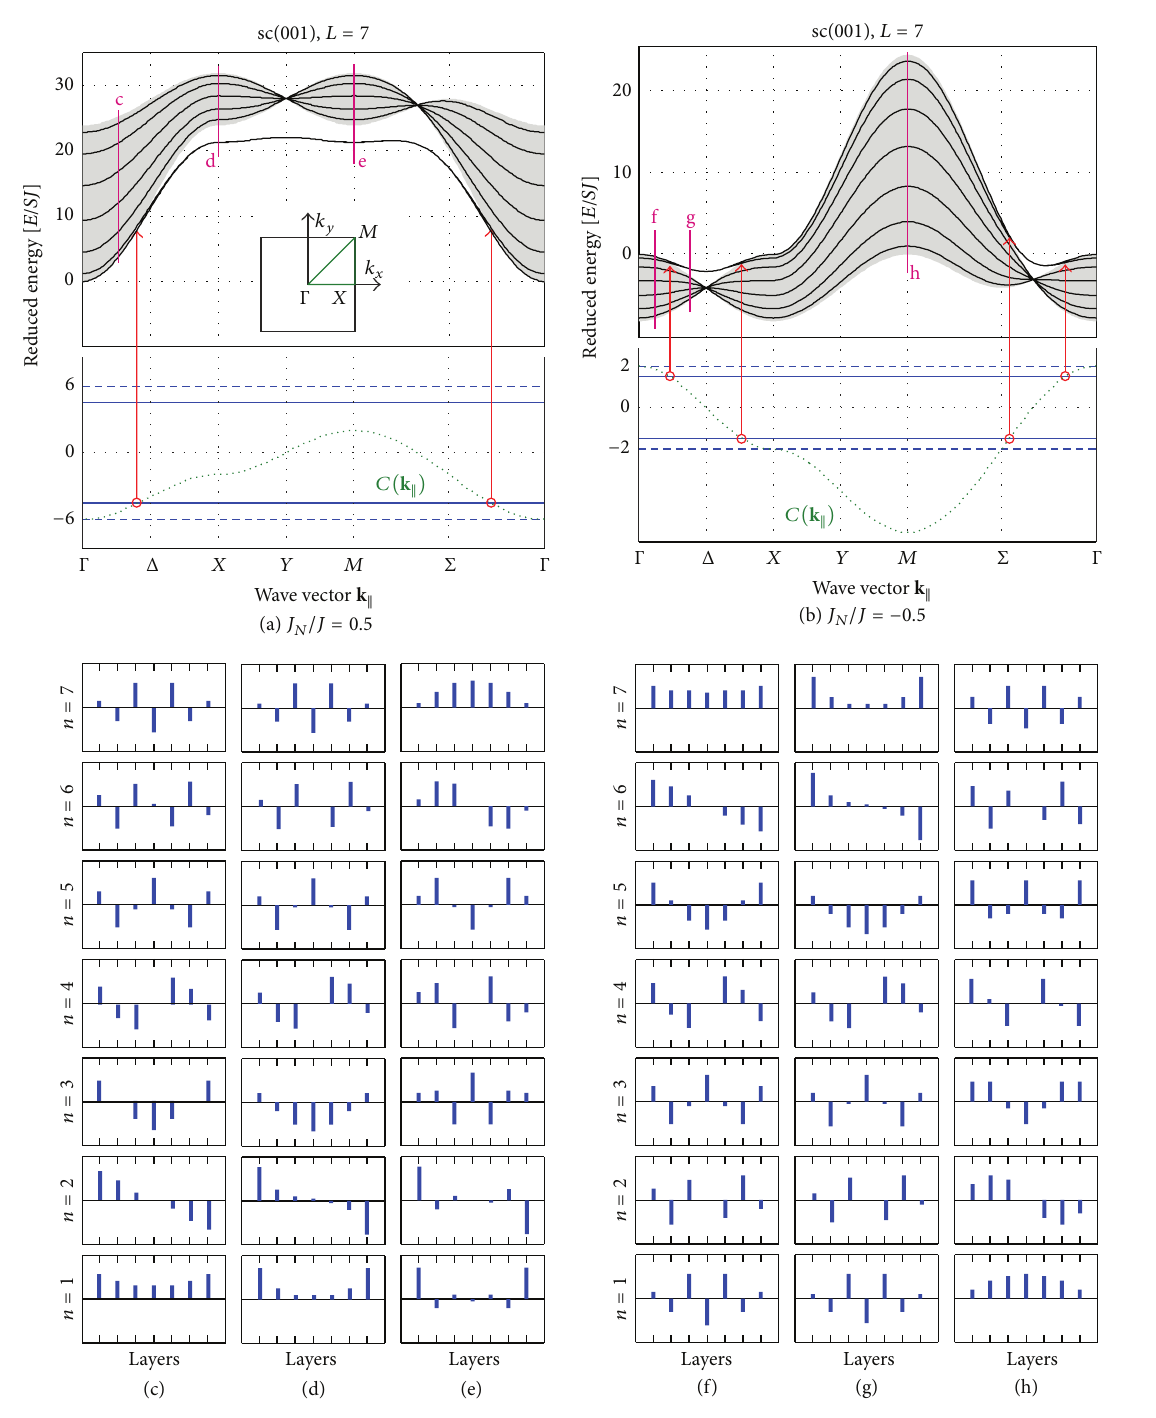
Figure 2: ((a), (b)) Spin-wave spectra of a 7-layer thick sc(001) thin film with NNN exchange interactions (a) ferromagnetic and (b) antiferromagnetic. Solid lines represent the energy of individual modes; the shaded area is the bulk band for in-plane spin waves. Each spectrum is plotted along the high-symmetry path shown in (a), inset. Below each spectrum the evolution of the off-diagonal Hamiltonian matrix element 𝐶 is shown as a green dotted line. Blue lines represent conditions for the surface localization of symmetric (solid lines) and antisymmetric (dashed lines) modes. Wave vectors for which the antisymmetric mode starts to localize are marked with red arrows. ((c)–(h)) Mode profiles corresponding to points in the SBZ marked with purple lines in ((a),